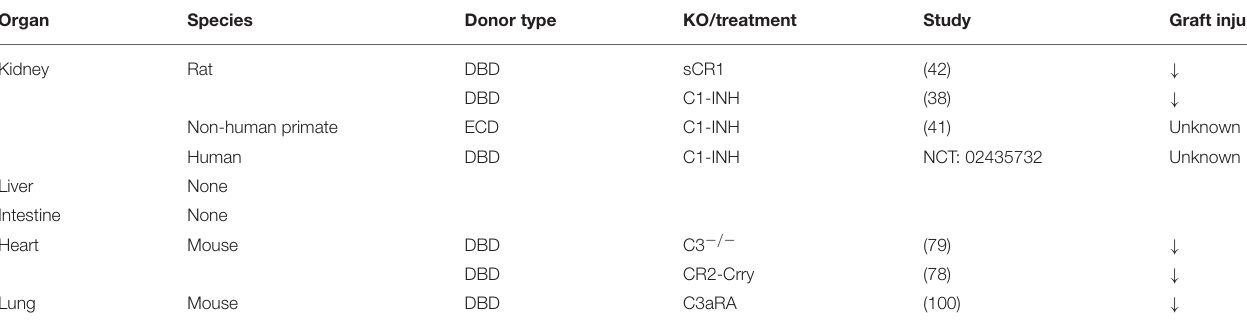
Inclusion criteria were: (1) All animal and human models, testing (2) complement targets or therapeutics applied in the organ donor or during preservation, with (3) the donor injury mechanism as a target of interest (e.g., DBD, DCD). Excluded are studies in which complement targets or therapeutics were tested in IRI or rejection as mechanisms of injury. ↓